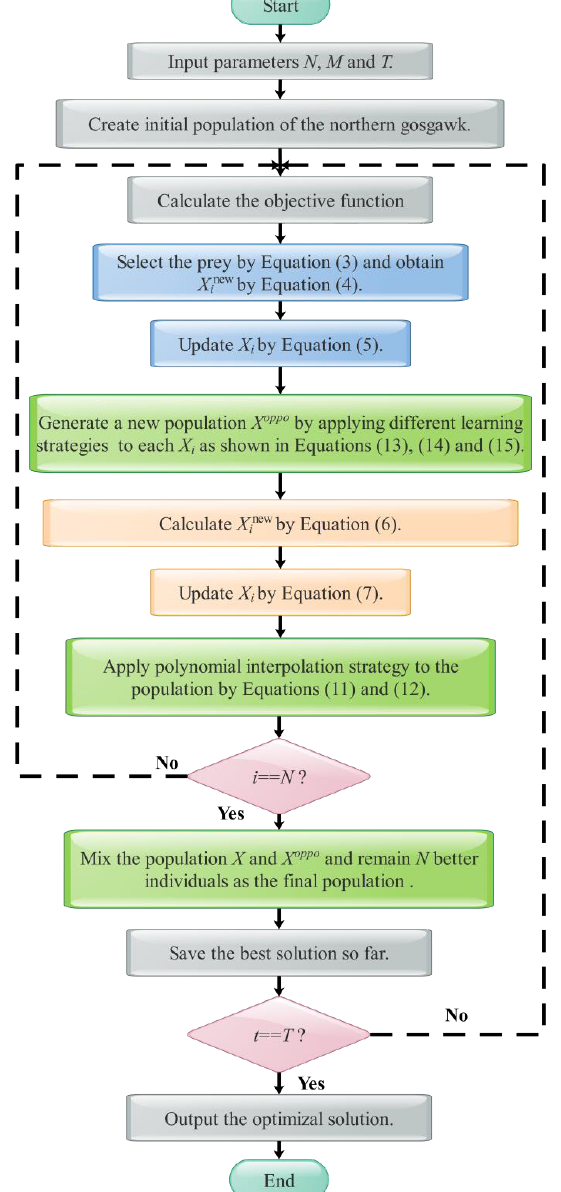
Figure 5. The flowchart of the ENGO algorithm.